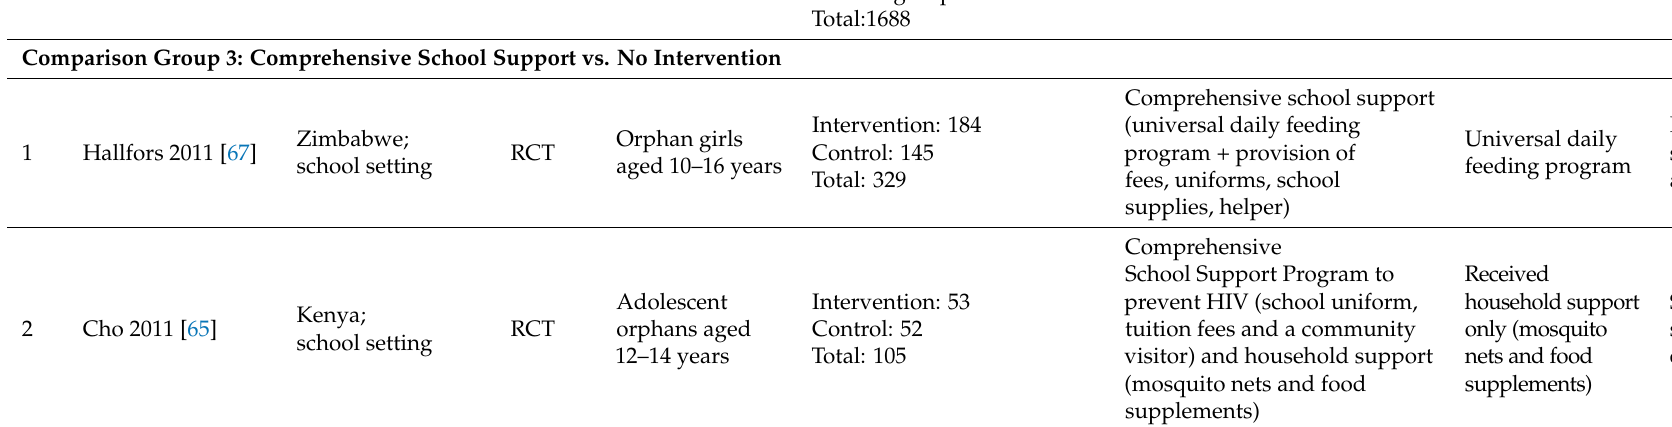
Comparison Group 3: Comprehensive School Support vs. No